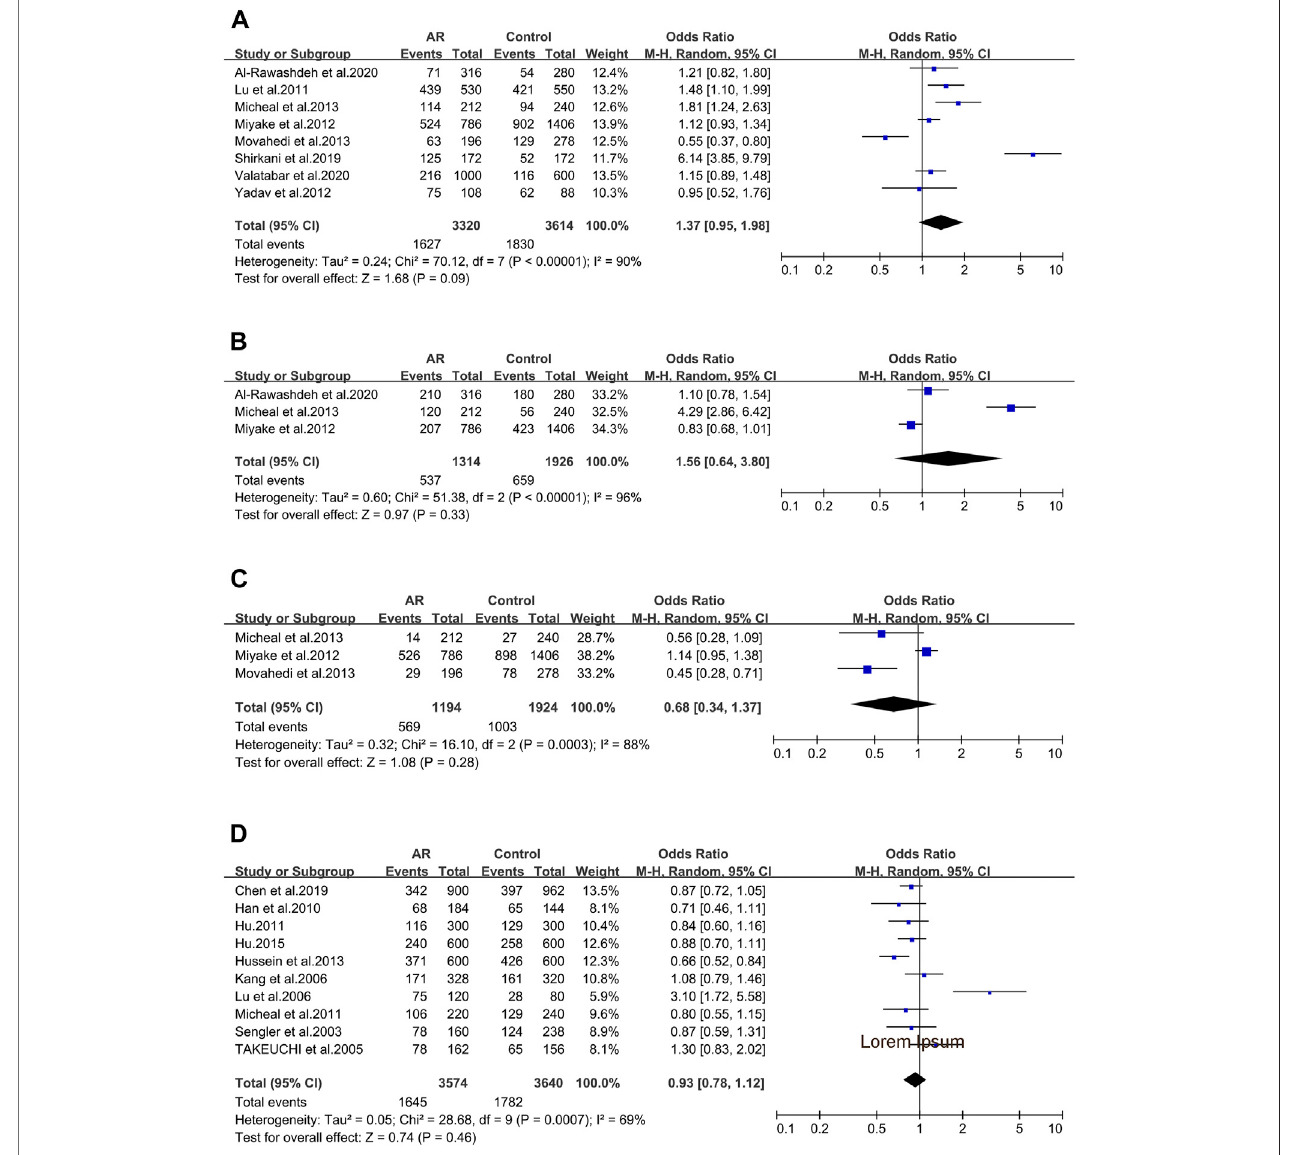
FIGURE 4 | Forest plots for IL-4 and CD14 polymorphisms. (A) IL-4 (rs2243250): T allele; (B) IL-4 (rs2227284): allele G; (C) IL-4 (rs2070874): allele T; (D) CD14 (rs2569190): allele T.